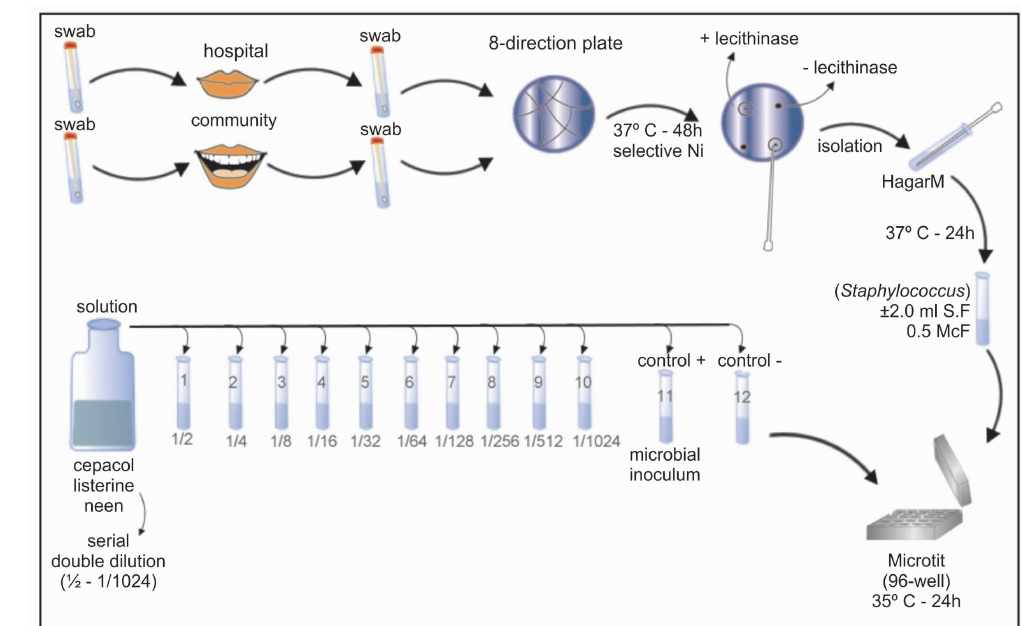
FIGURE 1 - Flow chart of antiseptic mouthwashes